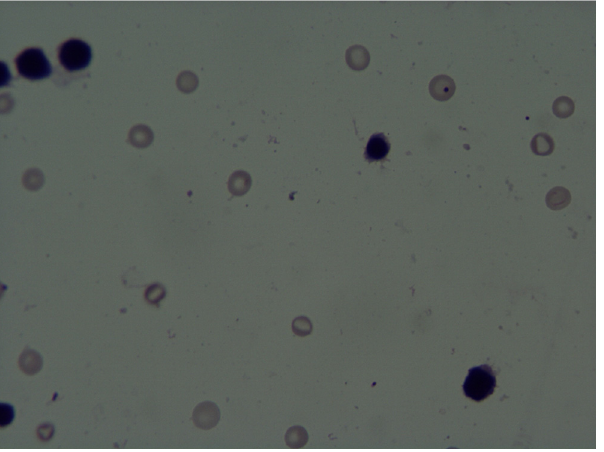
Fig 1. Micronucleus of mice bone polychromatic erythrocytes induced by the irrigative wastewater in Shijiazhuang city.